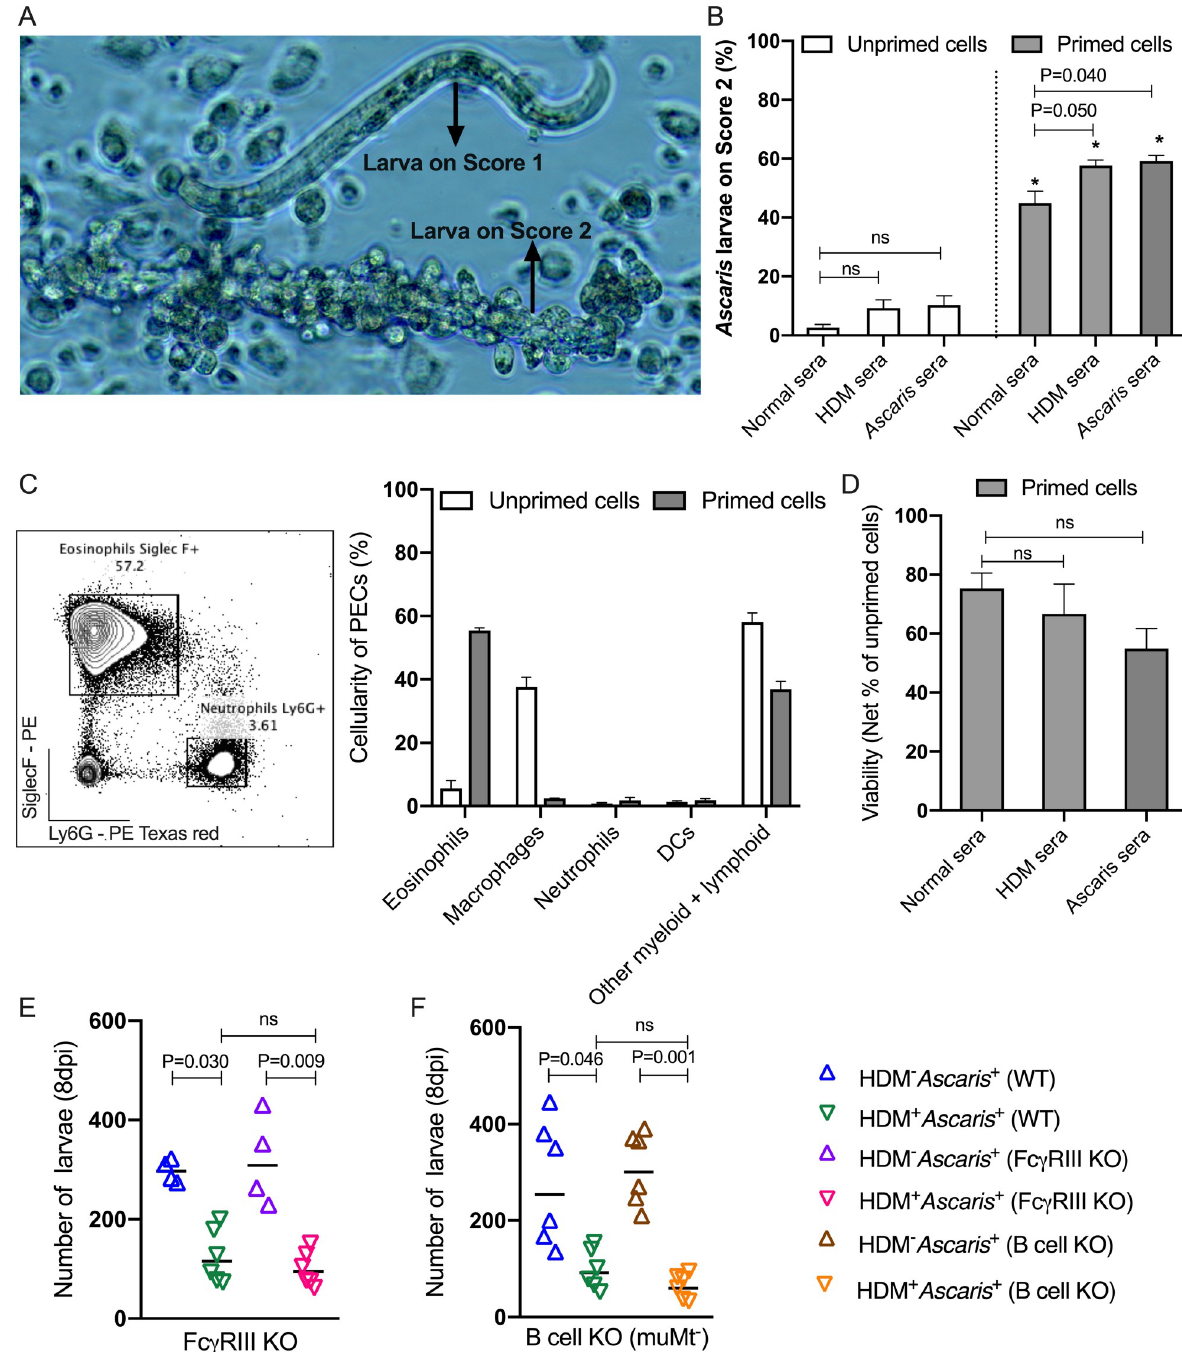
Fig 8. Antibodies may facilitate PEC adherence to Ascaris larvae but HDM-driven cross-reacted antibodies do not mediate larval killing. Larvae-associated peritoneal cavity cells (PECs) adherent the surface was assessed by microscopy and scored (1 for few to no adherent PECs and 2 for adherent PECs (A). Percentage of larvae with unprimed and primed PECs on their surface (Score 2) in the presence of the different sera pools (B). Representative flow cytometry dot plot for primed PECs and the frequency of the immunophenotyped cells (C). Larval viability measured by motility (D). Parasite burden in the lungs HDM – Ascaris + and HDM + Ascaris + WT C57/BL6 mice with HDM – Ascaris + and HDM + Ascaris + Fc γ RIII- deficient (E) and HDM – Ascaris + and HDM + Ascaris + muMt mice (F).